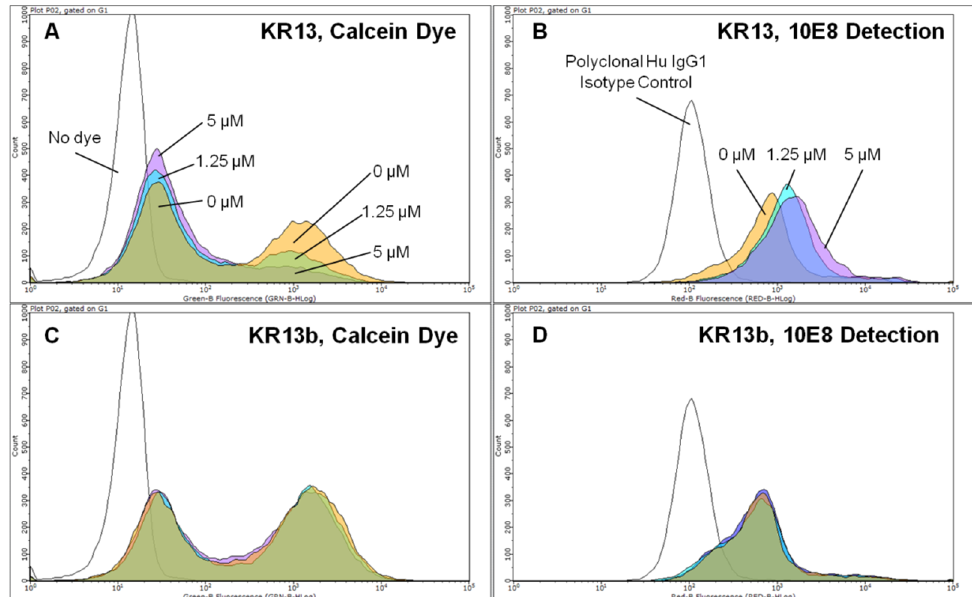
Figure 2. Sample histograms illustrating dose response to KR13 or KR13b at four concentrations. Open: No dye loaded/polyclonal Hu IgG1 isotype control. Orange: 0 µM inhibitor treatment. Cyan: 1.25 µM inhibitor treatment. Purple: 5 µM inhibitor treatment. ( A ) KR13 treatment, measuring for calcein retention. ( B ) KR13 treatment, measuring for 10E8 detection. ( C ) KR13b treatment, measuring for calcein retention. ( D ) KR13b treatment, measuring for 10E8 detection. Data shown are representative for one of four independent experiments. At least 5000 cells were examined for each condition in an independent